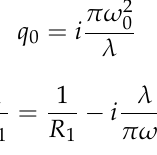
Figure 2. Geometric schematic of the lensed fi ber.